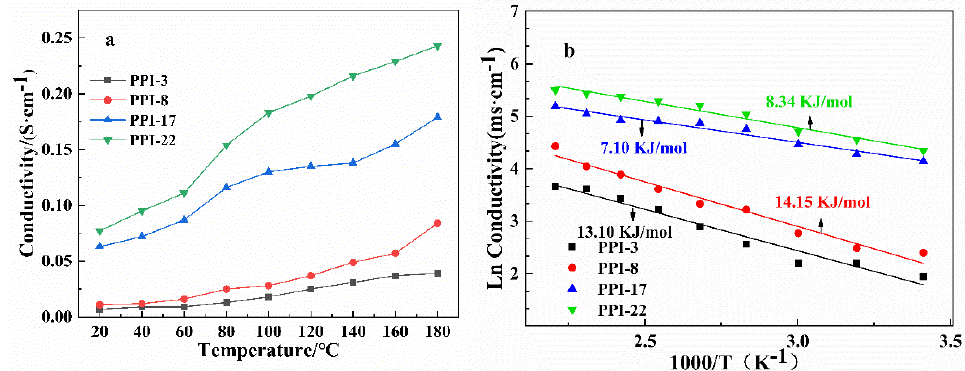
Figure 7. Proton conductivity of different doping level membranes ( a ) and Arrhenius plots with respect to temperature for bare PPI and composite membranes ( b ).